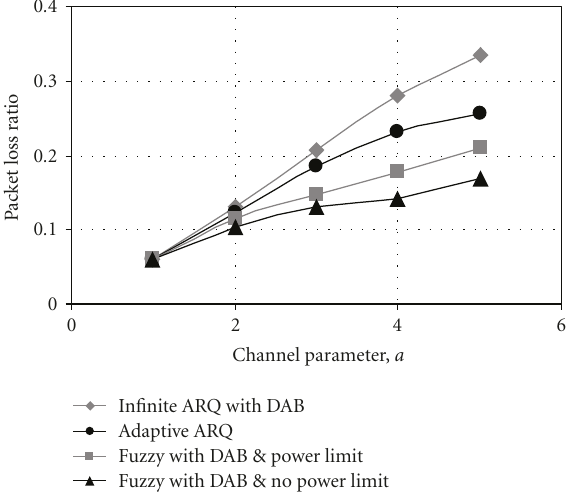
Figure 12: Packet loss during transmission of the “News” video clip, with the default scheme and the FLC power-aware scheme.